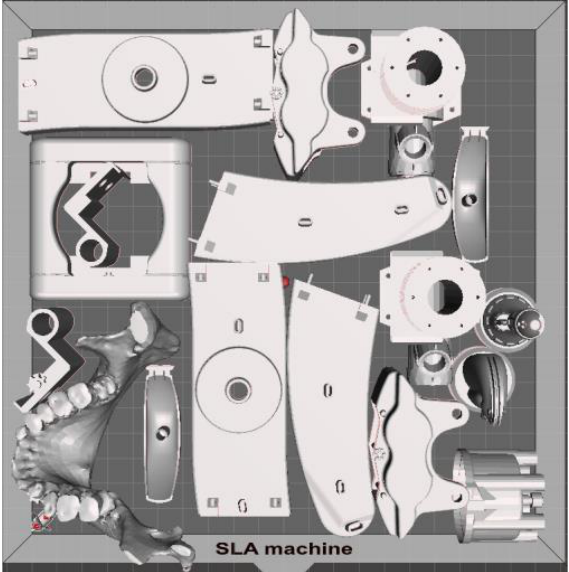
Figure 8. Nesting layouts for the test case data from [30] using the proposed method.